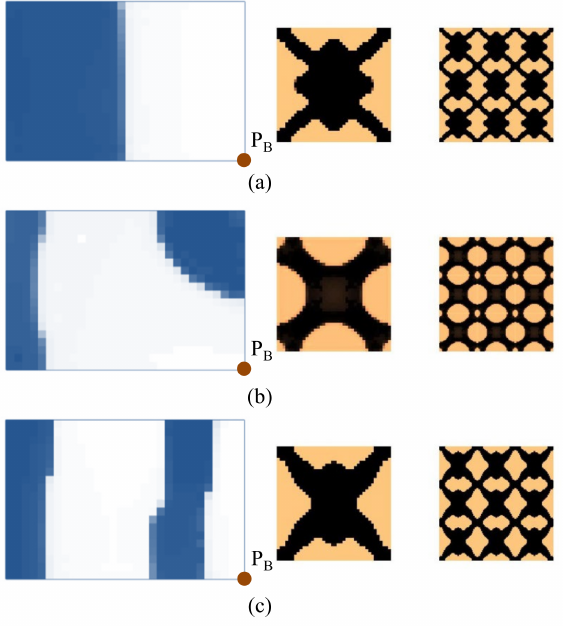
Figure 14. Comparison of three different designs by varying the excitation frequency. ( a ) Excitation frequency 60 Hz. ( b ) Excitation frequency 200 Hz. ( c ) Excitation frequency 400